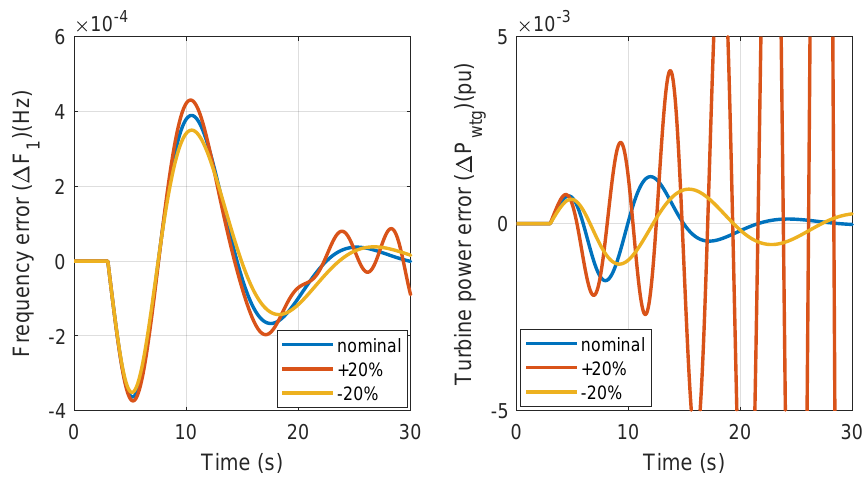
Figure 10. Robust performance of the frequency and turbine power error in the first and second subsystems against ± 20% concurrent changes in all subsystems parameters for the decentralized LQG controllers, subject to the load disturbance applied at t = 3 (s) with the amplitude of 0.01